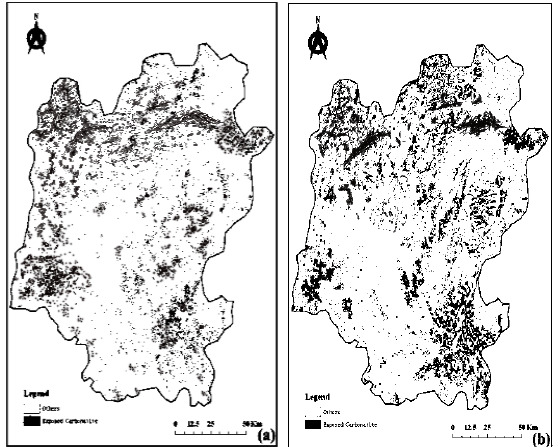
Figure 3. Comparison of remote sensing image classification